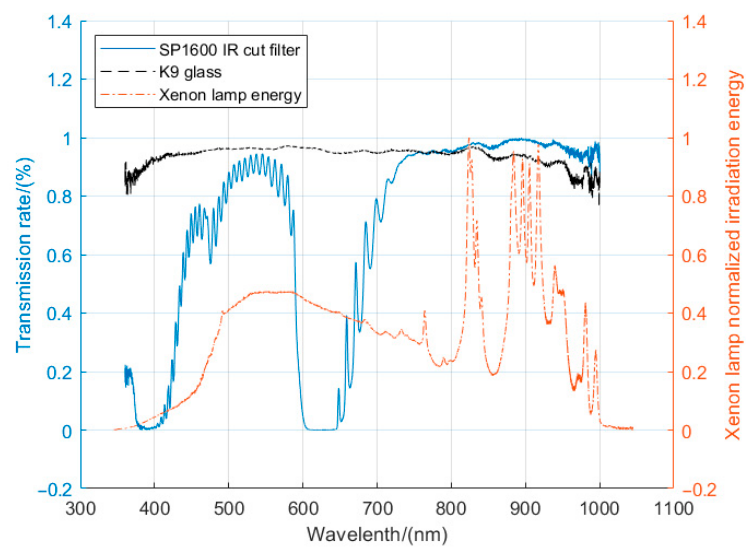
Figure 10. Comparison between the SP1600 long-wave cut-off filter transmission rate, theK9 glass transmission rate and the xenon lamp spectrum.